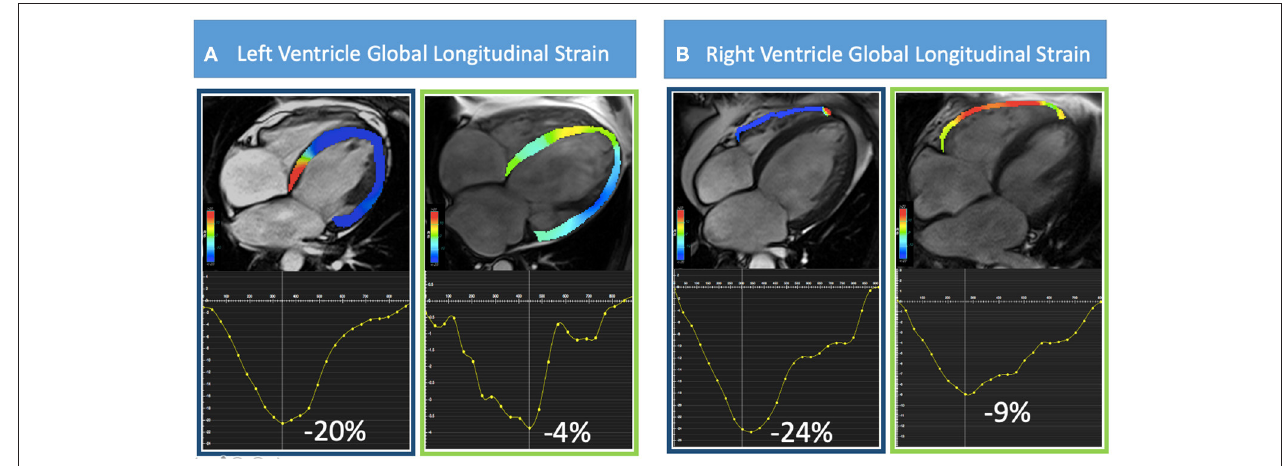
FIGURE 1 | Representative cases of CMR-FT analysis are shown. In (A) from left to right, a four-chamber view of patients with preserved ( − 20%) and reduced ( − 4%) LV-GLS and in (B) preserved ( − 24%) and reduced ( − 9%) RV-GLS are